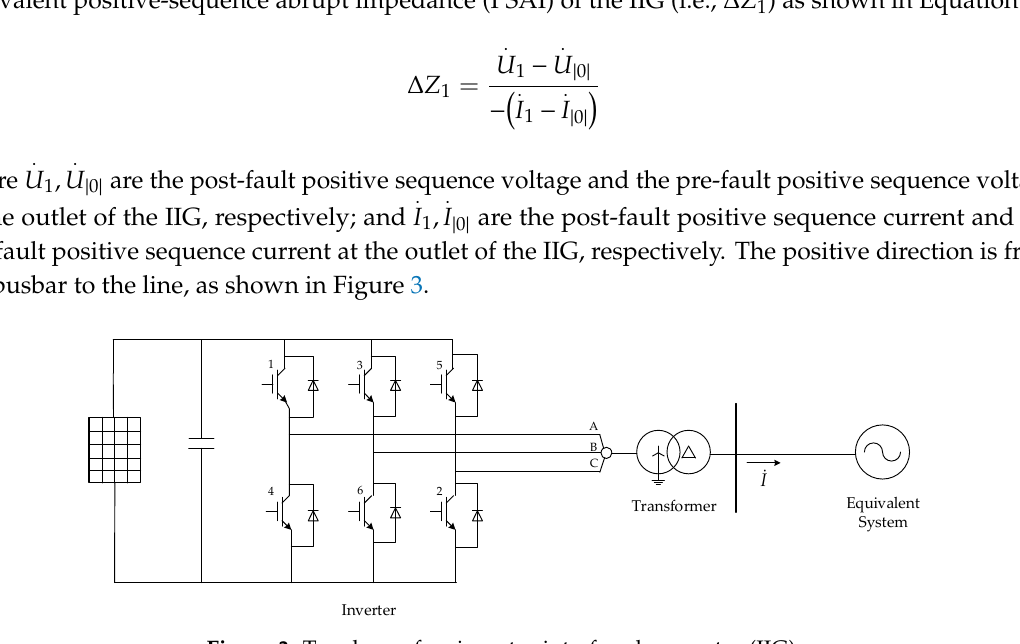
Figure 3. Topology of an inverter-interfaced generator (IIG).